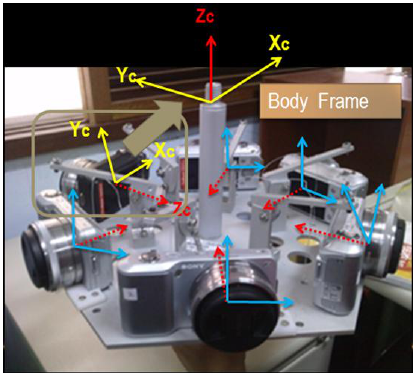
Figure 5. The body frame and the camera frames of PPIMS.